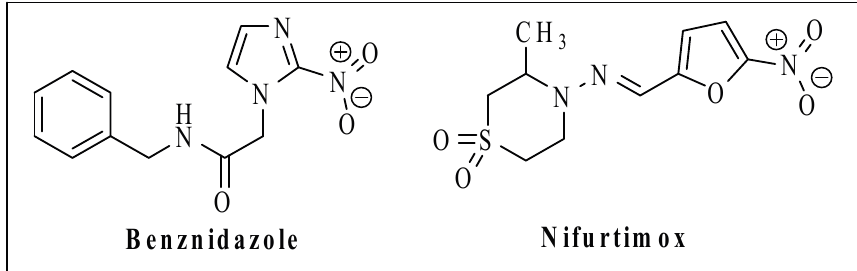
Figure 2. Chemical structures of benznidazole and